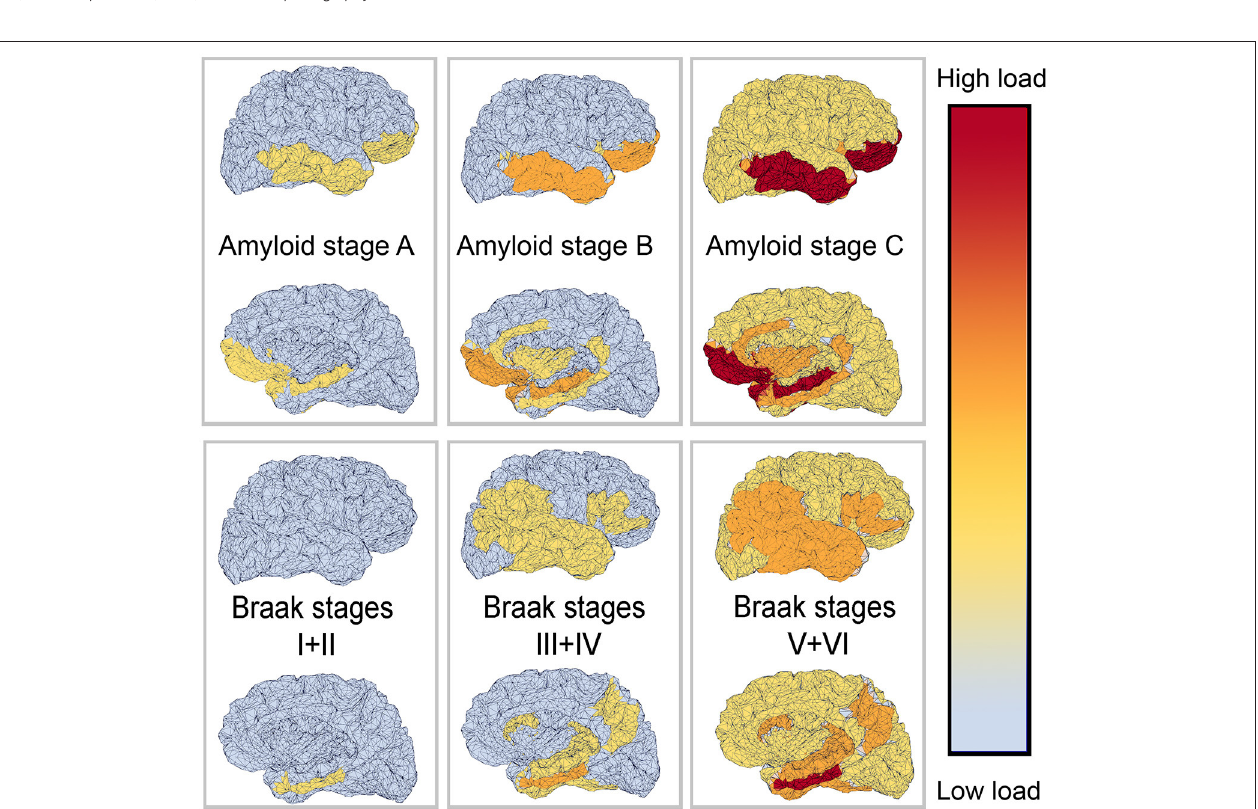
FIGURE 4 | Visual representation of Abeta and Tau stages according to Braak and Braak (1991, 1997), and Braak et al. (2006). The darker color indicates a higher load of this protein in the respective brain area. The regions are listed in Tables 3 , 4